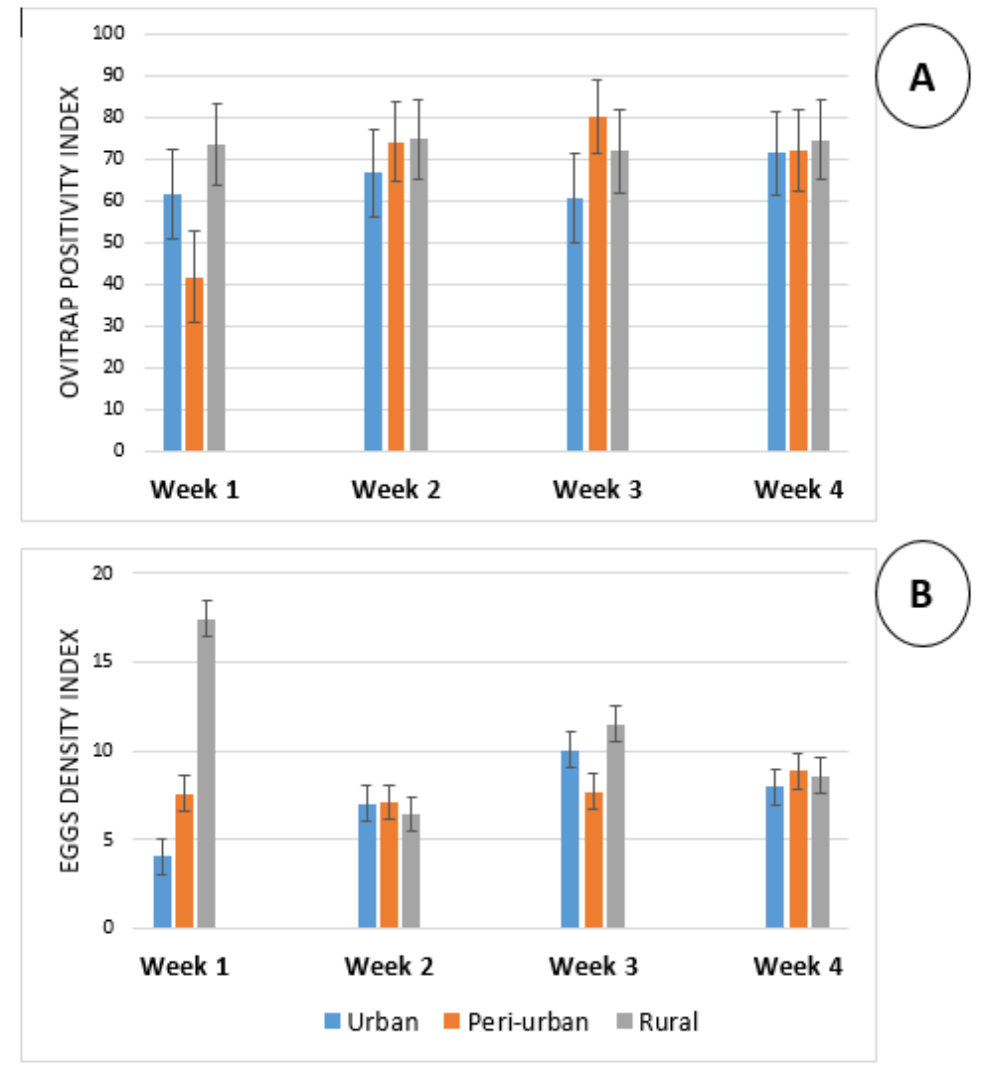
Figure 3. Weekly variation of Ovitraps Positivity Index ( A ) and Eggs Density Index ( B ) around human dwellings.